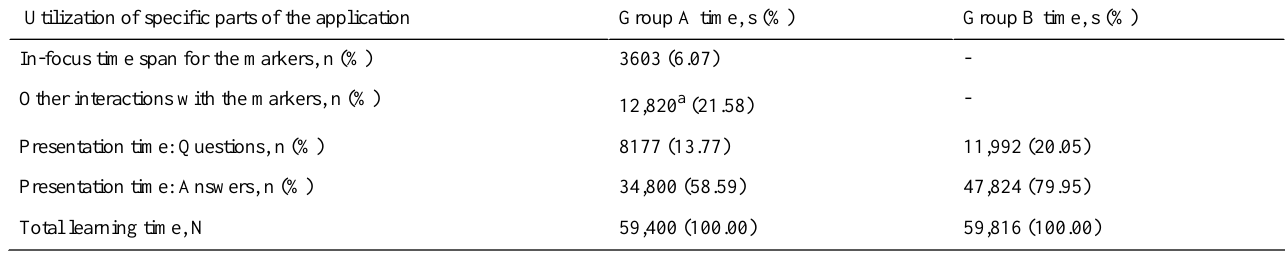
Table 4. Combined utilization times in seconds, including in-focus time spans for the markers, interaction time span, and presentation times for both question and answer parts of the flashcards, stratified by group (group A with mobile Augmented Reality [mAR], group B without mAR functionality, both n=22).